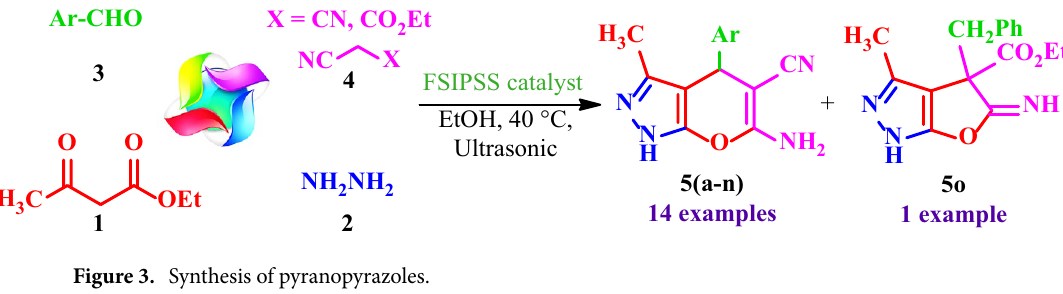
Figure 3. Synthesis of